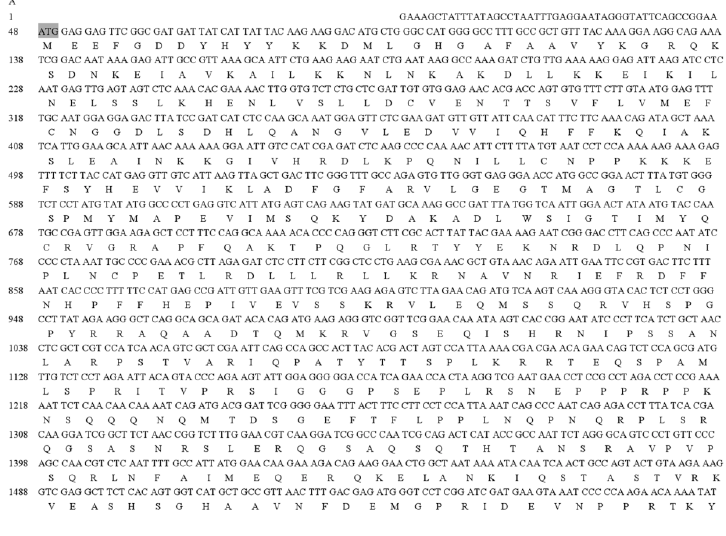
Figure 1. Autophagy in the cells of the highly virulent strain AmA3 of Bursaphelenchus xylophilus after starvation was induced for 12 h ( A , B ); 24 h ( C ); and 36 h ( D ), with autophagic bodies (right arrows), autophagosomes (left arrows), autolysosomes (down arrows) and vesicle breakdown (up arrows) Scale bars: ( A ) 0.2 µm; ( B ) 0.5 µm; ( C ) 1 µm; and ( D ) 2 µm.